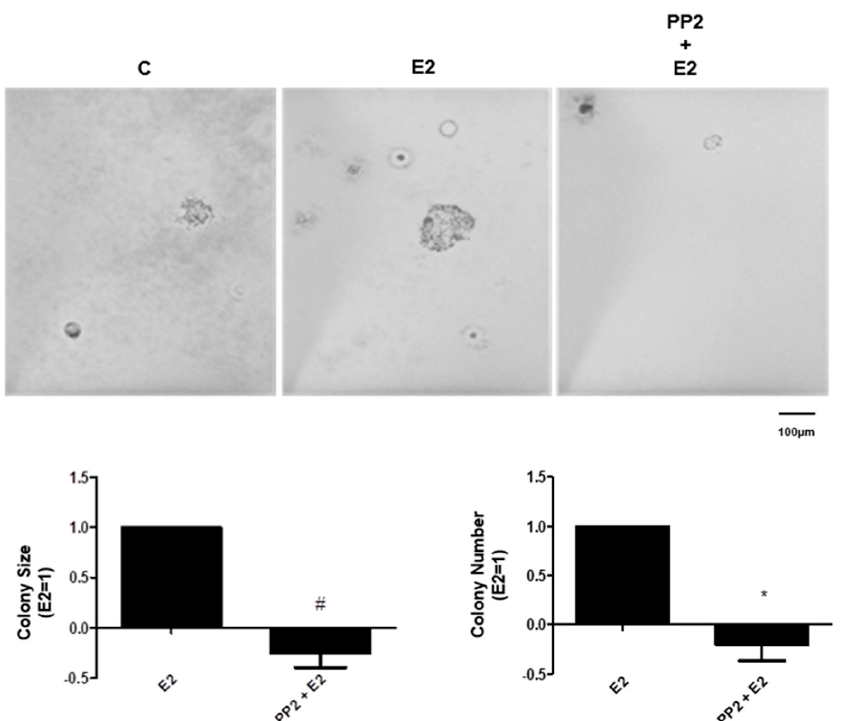
Figure 5. Effects of the selective inhibitor for SRC-family kinases (PP2) on size and number of the colony formed by androgen-independent prostate cancer cells PC-3 induced by 17 β -estradiol (E2). Cells were incubated in the absence (C, control) and in the presence of 17 β -estradiol (10 nM) for 3 weeks at 37 °C. The cells were also pre-treated with PP2 (5 nM) for 30 min and then incubated or not with E2. Representative image of PC-3 cell colony formation assays. The images were acquired, and the area of each colony was measured by the Image J software, and then the values obtained were expressed in relation to E2 and subtracted from the control (E2 = 1). The colonies were also counted with Zen software and the values of the number of colonies were expression in relation to E2 and subtracted from the control (E2 = 1). Results are expressed as (mean ± SEM) of three independent experiments. # Significantly different from E2 ( p < 0.05, Student t -test) by #, * Significantly different from E2 ( p < 0.05, Student t -test.